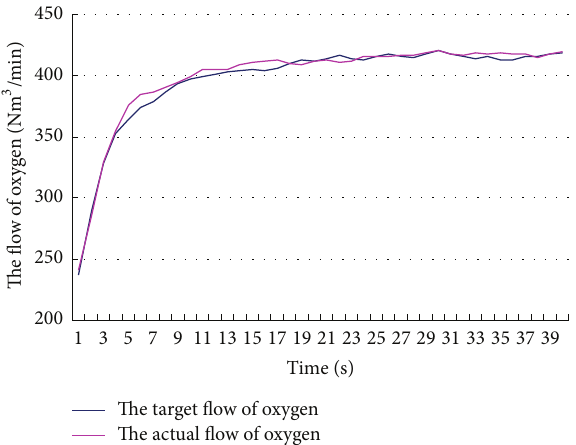
Figure 10: Comparison between detection actual CO and CO 2 content of off-gas and reference